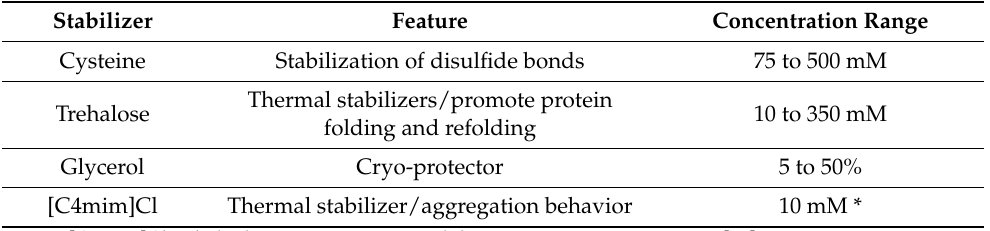
Table 2. hSCOMT stabilizers features and concentrations. Stabilizer Feature Concentration Range Cysteine Stabilization of disulfide